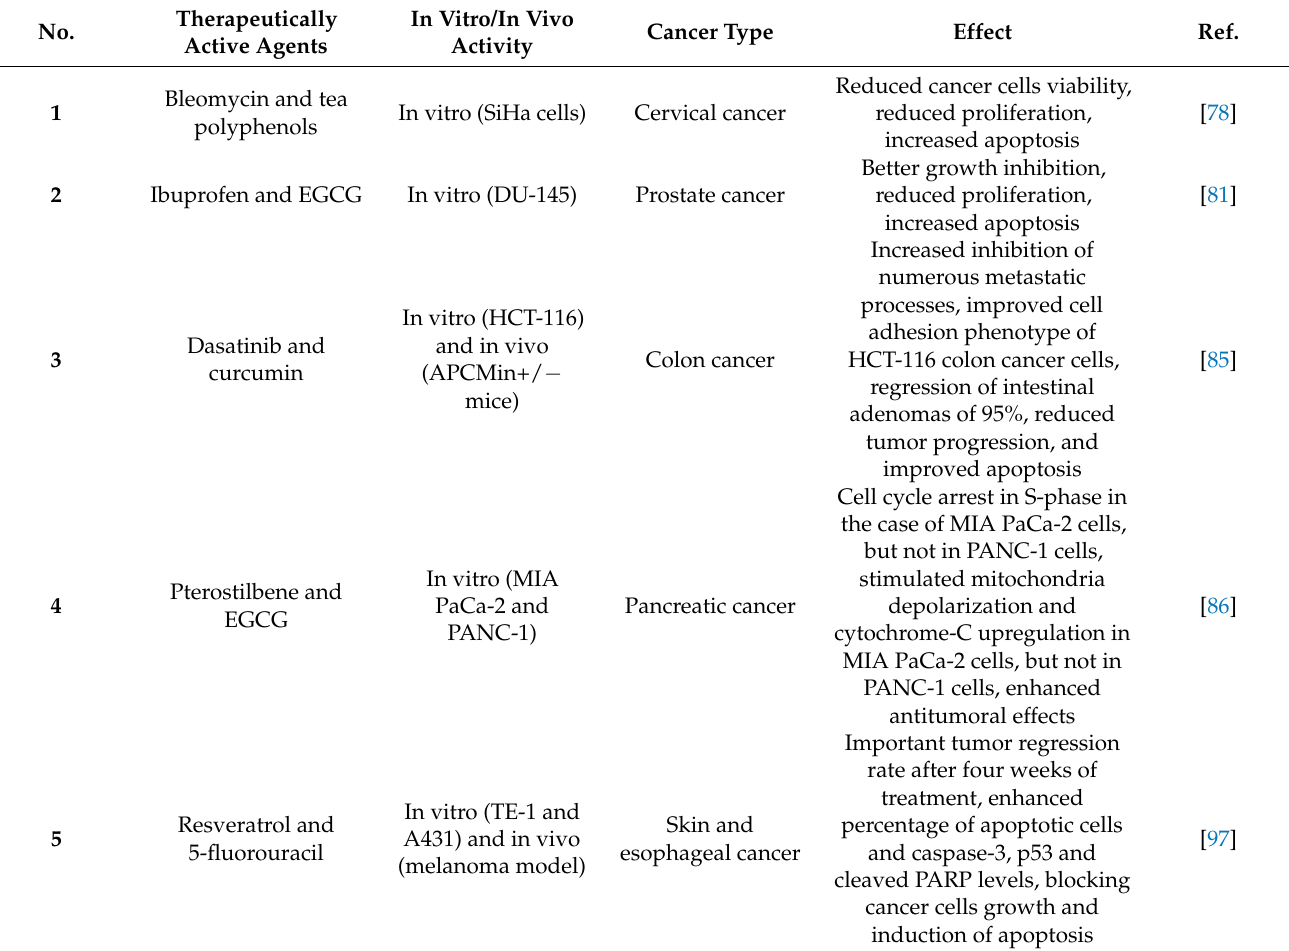
Table 3. The synergies in cancer multicomponent